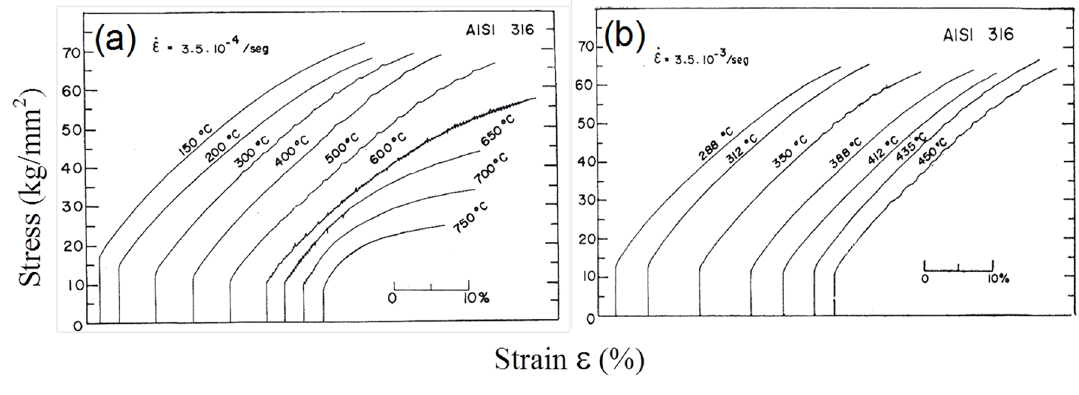
Figure 1. Typical stress-strain curves for type AISI 316 stainless steel tested at different temperatures and two strain rates: (a) 3.5 x 10 -4 and (b) 3.5 x 10 -3 s -1 .